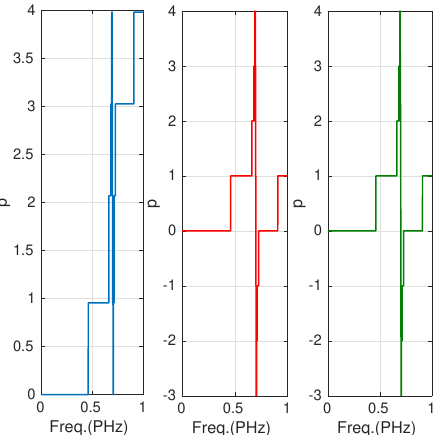
Figure 2. Plot of n ef f ( ω ) , as a function of n s , and n ex ( ω ) for the MM with d ef f = 180 nm over the frequency band [ 0,1 ] PHz. Top left : PUNWOS method; top right : PUNW HT method; bottom left : K-K relations; bottom right : PUNW KK method. The insets magnify n ef f ( ω ) around its peaks.